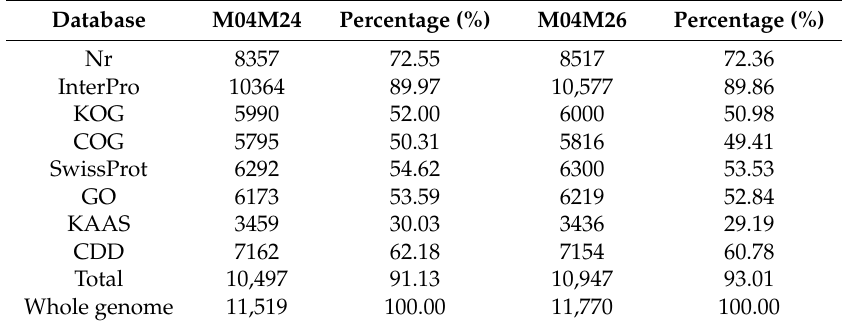
Table 2. Gene annotation results of the two opposite-polarity monospore of Morchella importuna